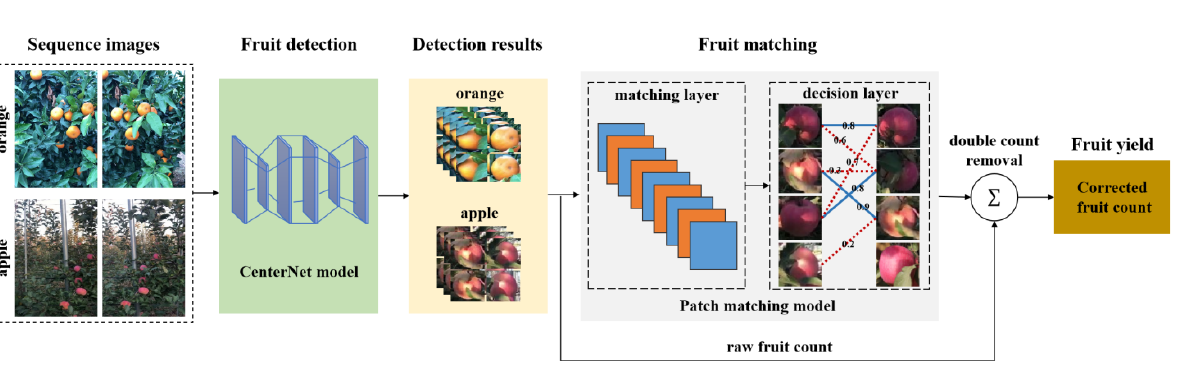
Figure 4. The network architecture of the CenterNet detector.